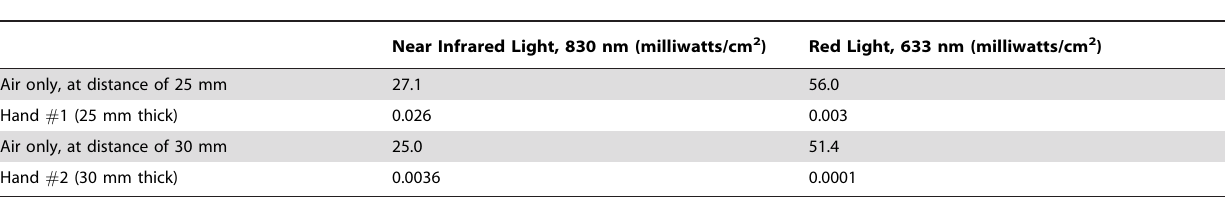
Table 5. Transmission of Near Infrared and Red Light through